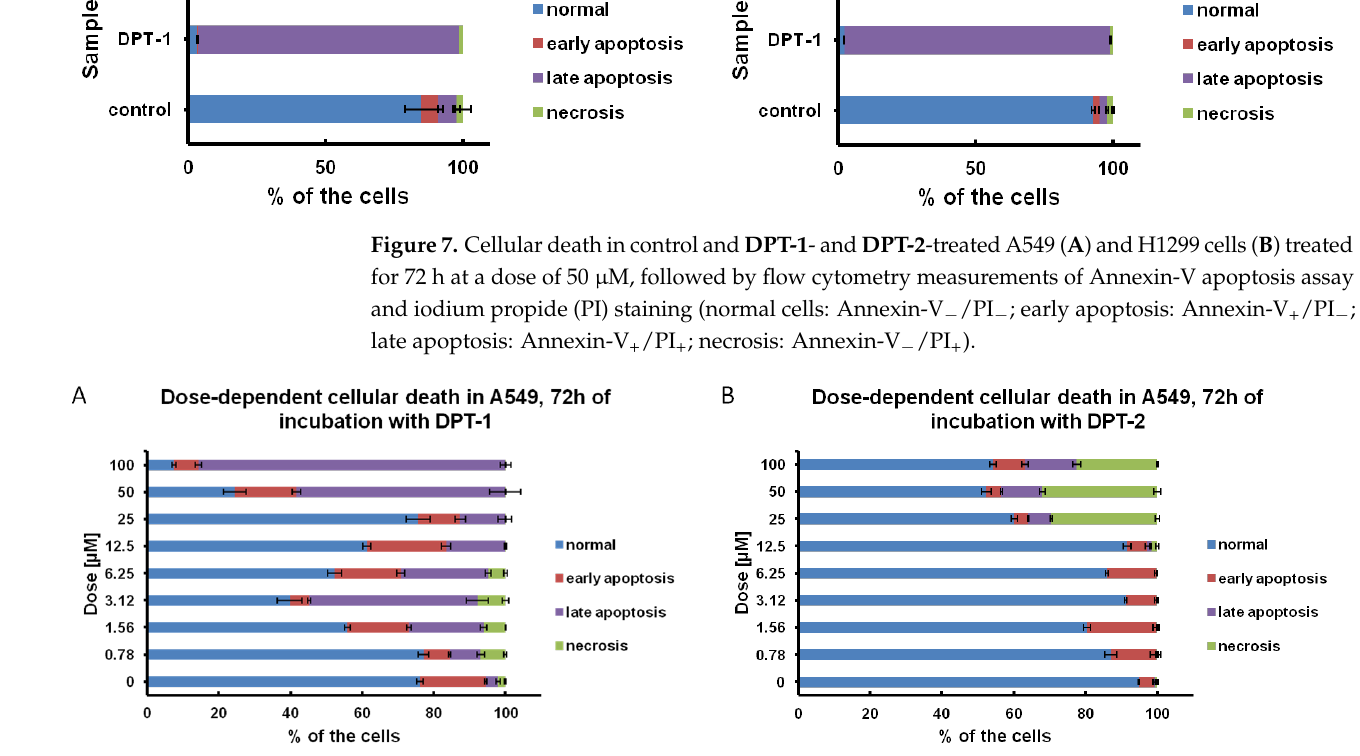
Figure 7. Cellular death in control and DPT-1 - and DPT-2 -treated A549 ( A ) and H1299 cells ( B ) treated for 72 h at a dose of 50 µM, followed by flow cytometry measurements of Annexin-V apop- tosis assay and iodium propide (PI) staining (normal cells: Annexin-V − /PI − ; early apoptosis: An- nexin-V + /PI − ; late apoptosis: Annexin-V + /PI + ; necrosis: Annexin-V − /PI + ).